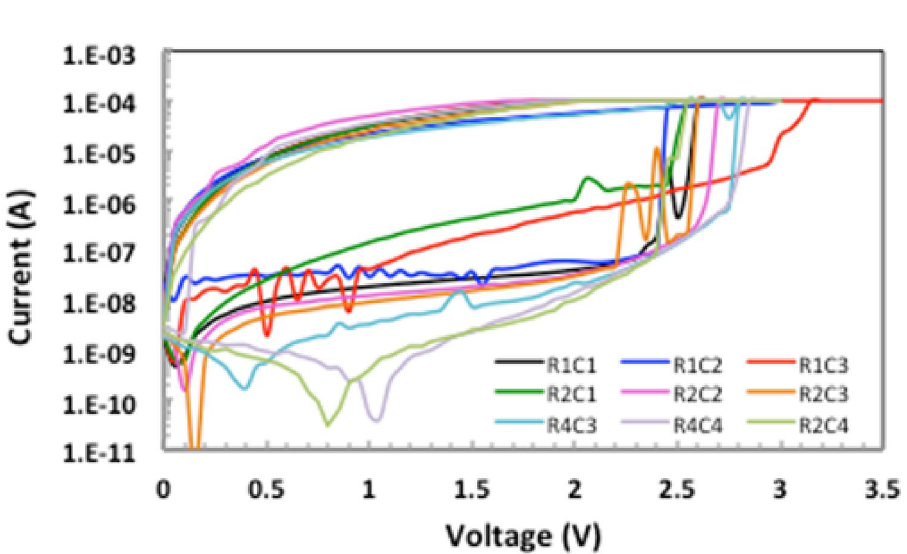
Figure 6. I–V characteristics obtained from identical memristor devices. Memristors fabricated on the same wafer using the same features and material compositions, each device has its own I-V